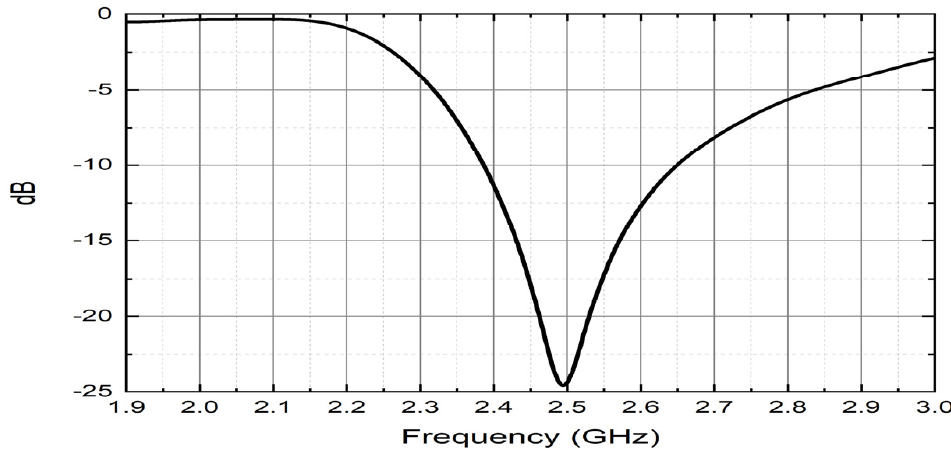
Figure 5. Reflection coefficient of the antenna. Table 1. ESPAR antenna design parameters.